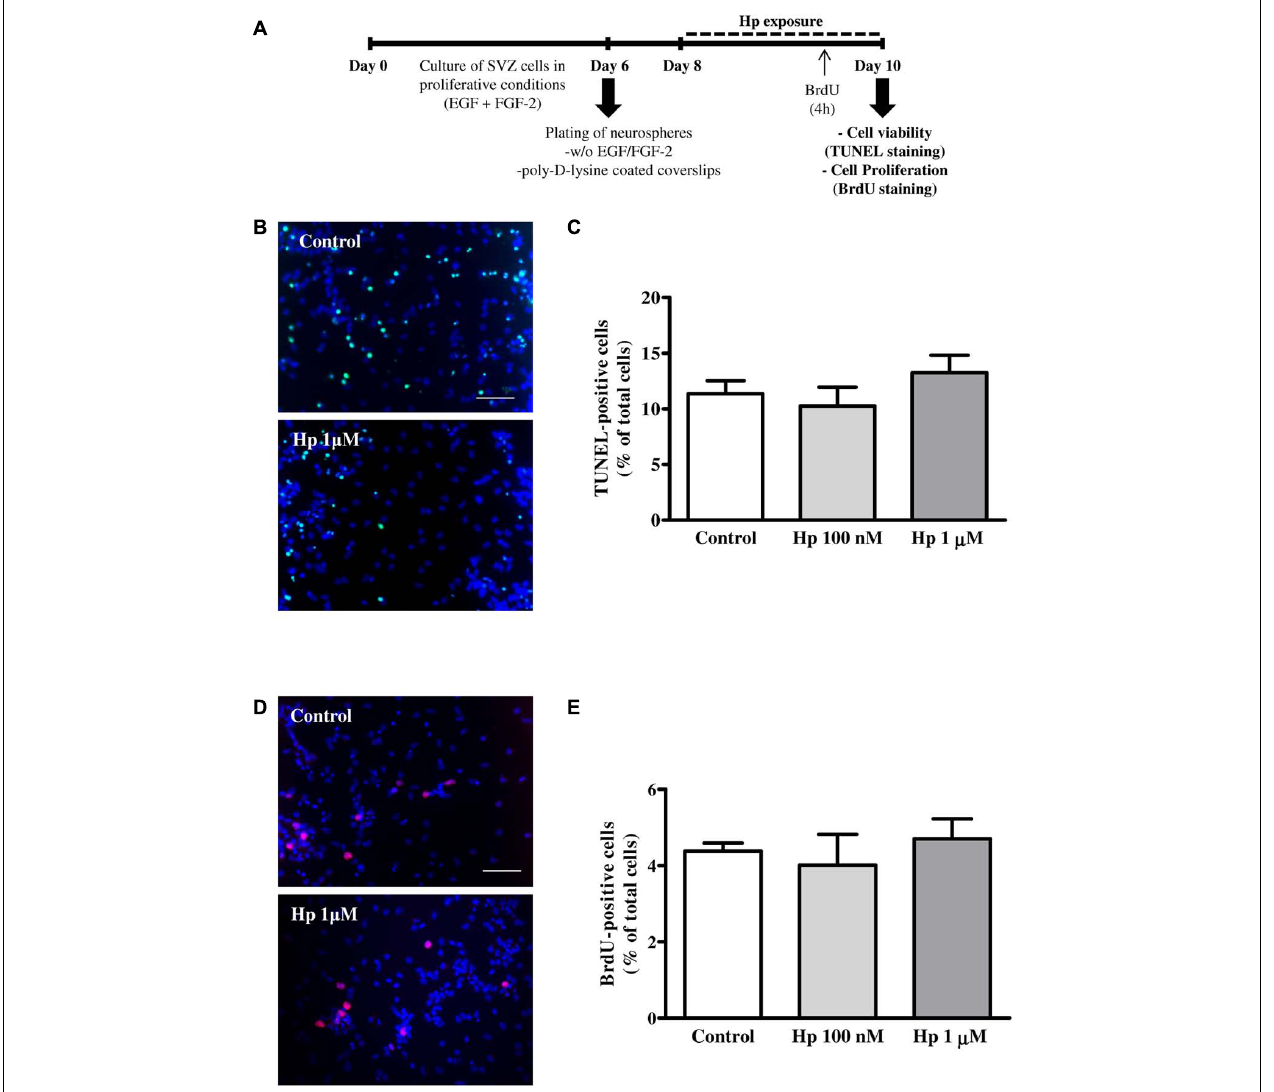
FIGURE 1 | Hp did not induce cell death nor cell proliferation. (A) Experimental protocol. (B) Representative fluorescence digital images of SVZ cell cultures treated for 48 h in the absence (control) or presence of Hp (1 μ M) and stained using theTUNEL (Terminal deoxynucleotidyl transferase dUTP nick end labeling) method to reveal apoptotic nuclei (in green) and Hoechst 33342 (blue nuclei). (C) Bar graph depicts the percentages of